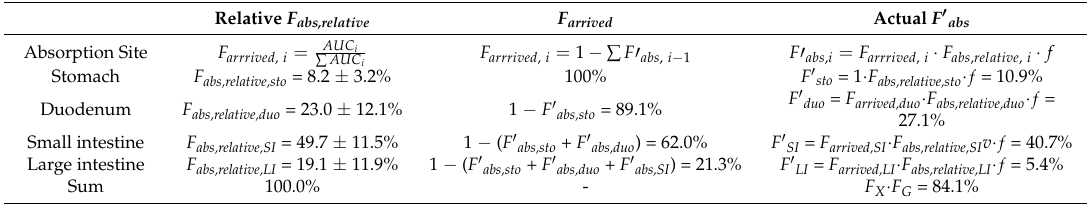
Table 4. Fraction absorbed ( F abs ) of fimasartan in different gastrointestinal regions determined by the improved in situ absorption model ( n = 4, mean ±